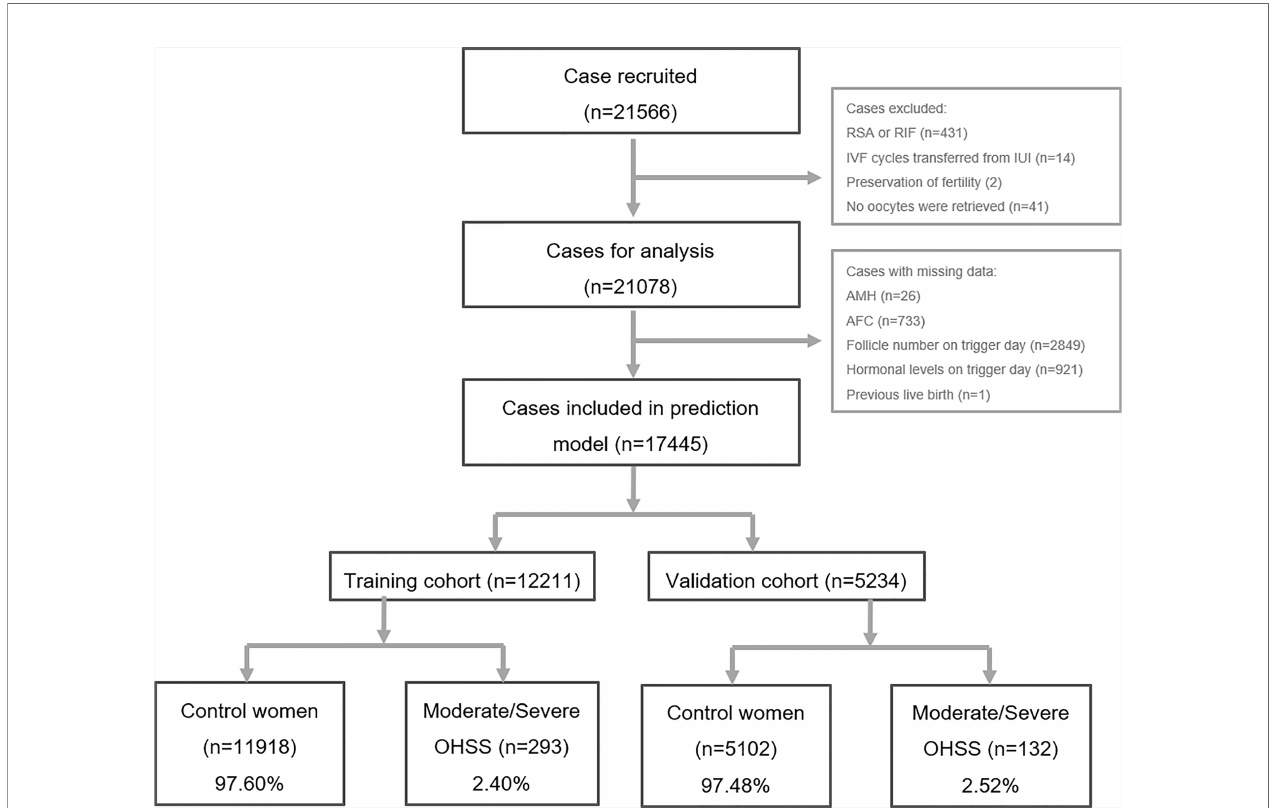
FIGURE 1 | Flowchart of patients ’ data inclusion and exclusion. RSA, repeated spontaneous abortion; RIF, repeated implantation failure; IVF, in vitro fertilization; IUI, intrauterine insemination; AMH, anti-Mullerian hormone; AFC, antral follicle counting; OHSS, ovarian hyper-stimulation